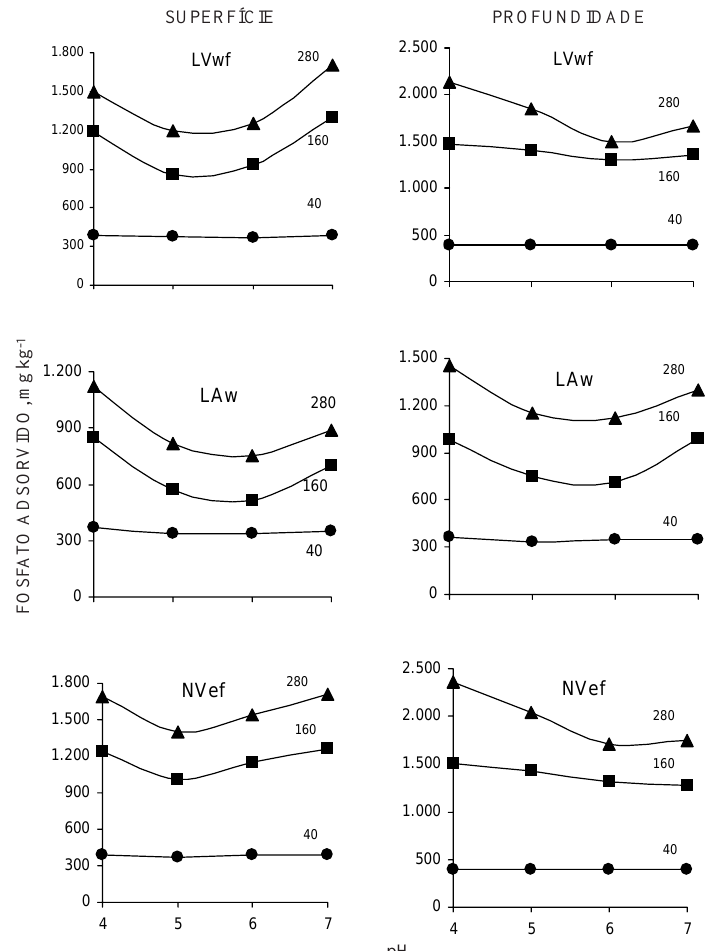
Figura 1. Fosfato adsorvido em função do pH para Latossolo Vermelho acriférrico (LVwf), Latossolo Amarelo ácrico (LAw) e Nitossolo Vermelho eutroférrico (NVef) em superfície e profundidade, para as doses de 40, 160 e 280 mg kg -1 de